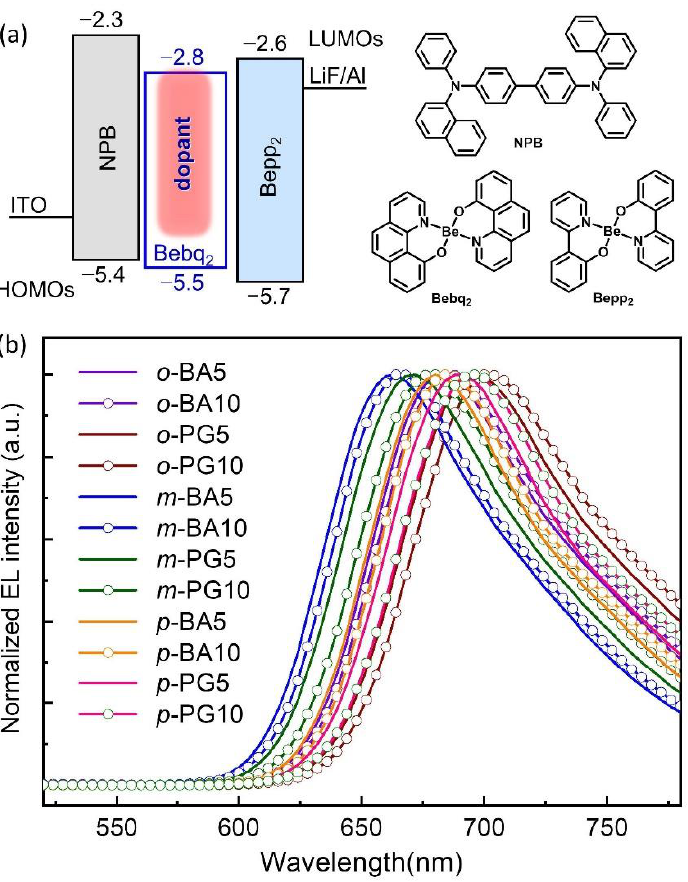
Figure 4. ( a ) Schematic energy level diagram of all the devices and chemical structures of various materials being used. ( b ) EL spectra of all the devices with the luminance of 100 cd m −2 .